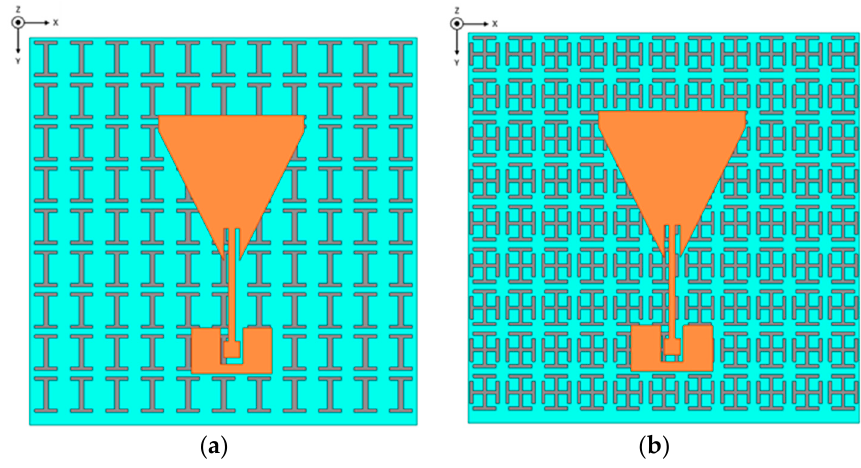
Figure 9. The type of the proposed AMC: ( a ) Type 1; ( b ) Type 2.